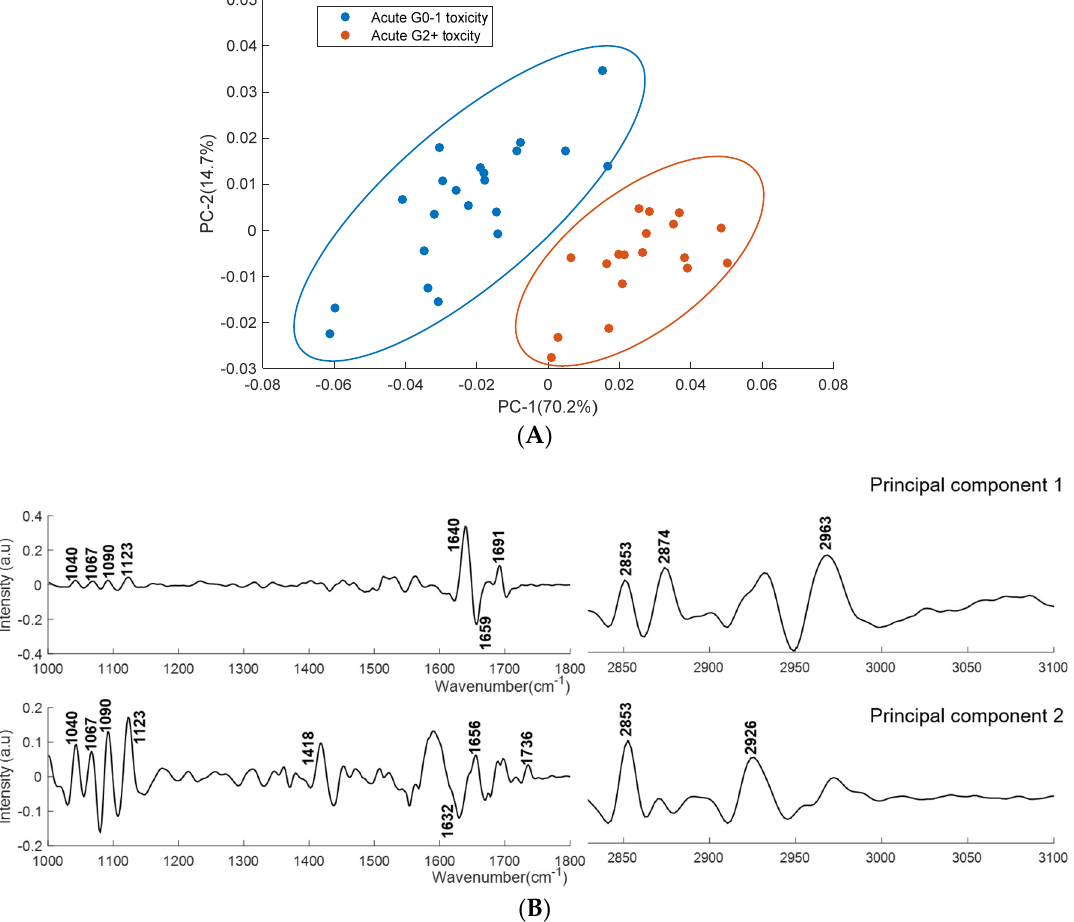
Figure 7. PCA for plasma spectra from patients showing acute grade 0–1 and acute grade 2+ toxicity. ( A ) Score plots are shown for patients showing acute grade 0–1 (blue) and acute grade 2+ toxicity (red). ( B ) PC-1 and PC-2 loading plots for regions 1000–1800 cm − 1 and 2800–3100 cm − 1 . Covariance ellipses (95% confidence) are shown for each class.